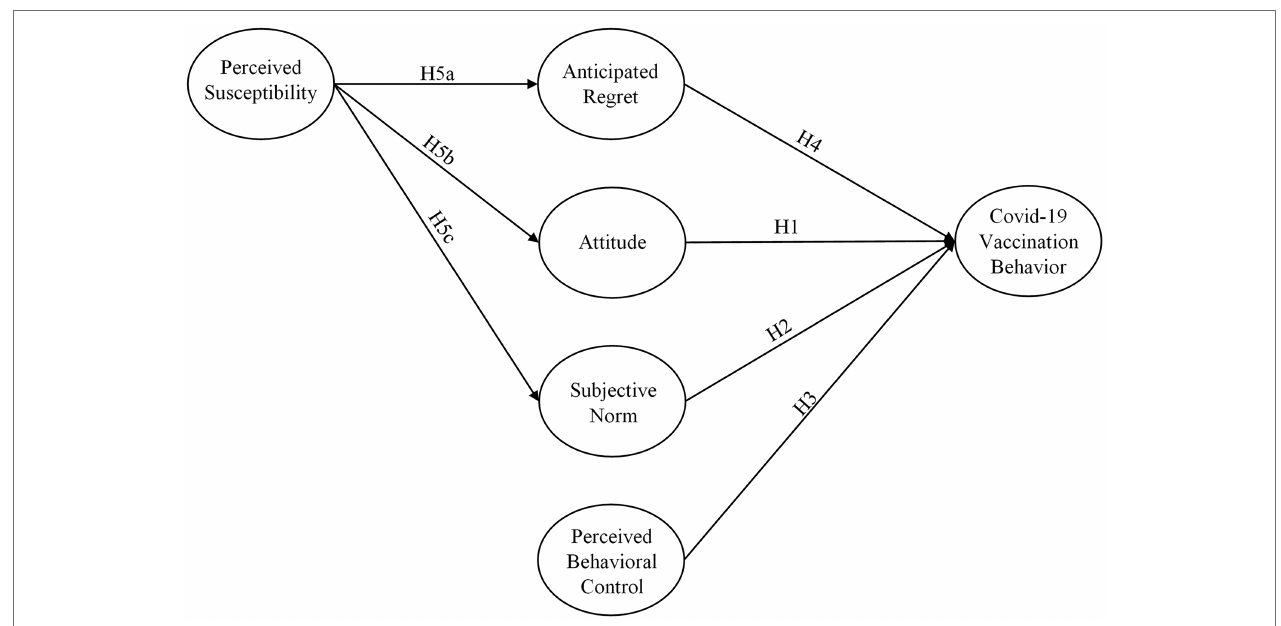
FIGURE 1 | Hypothesized COVID-19 vaccination